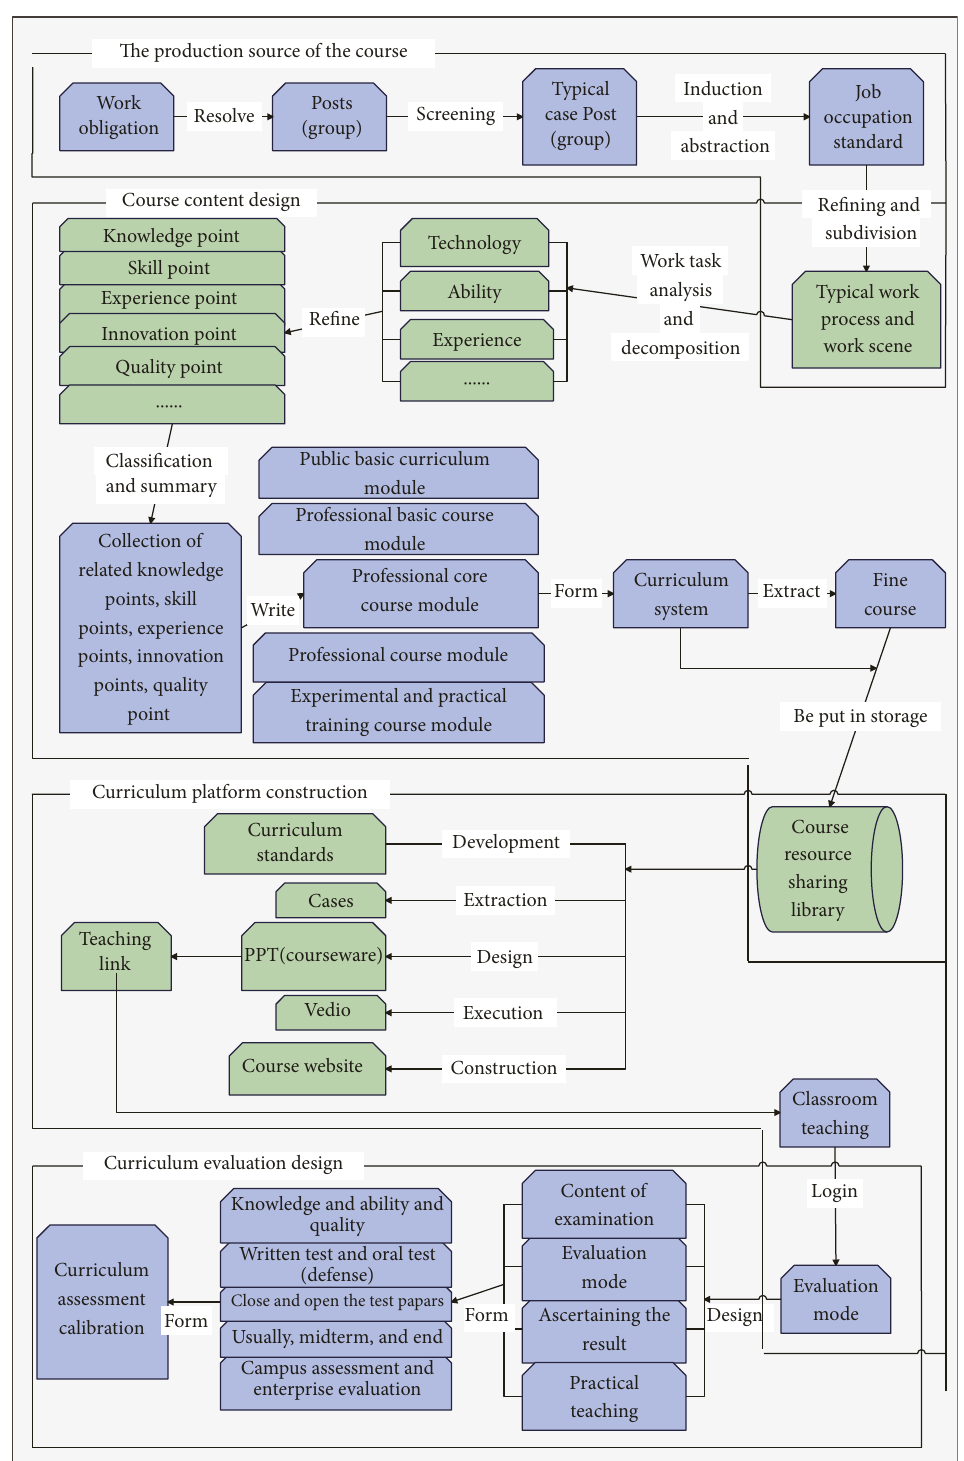
Figure 8: The training process of intelligent transportation technology professionals under the background of integration of production and